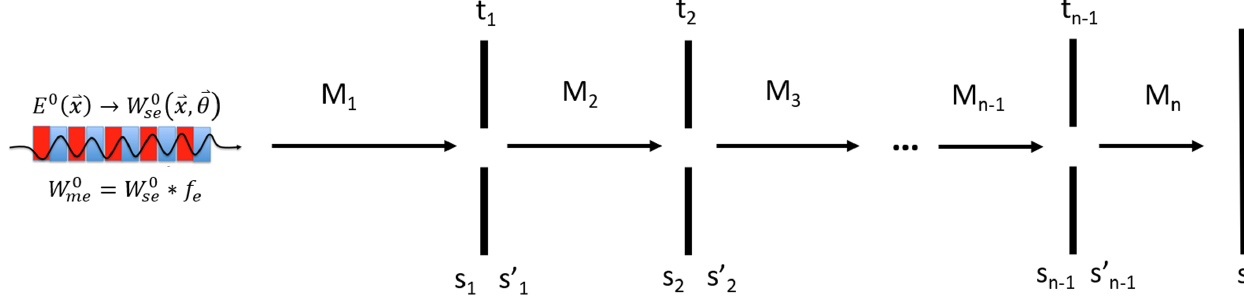
FIG. 1. Matrix aperture beam line